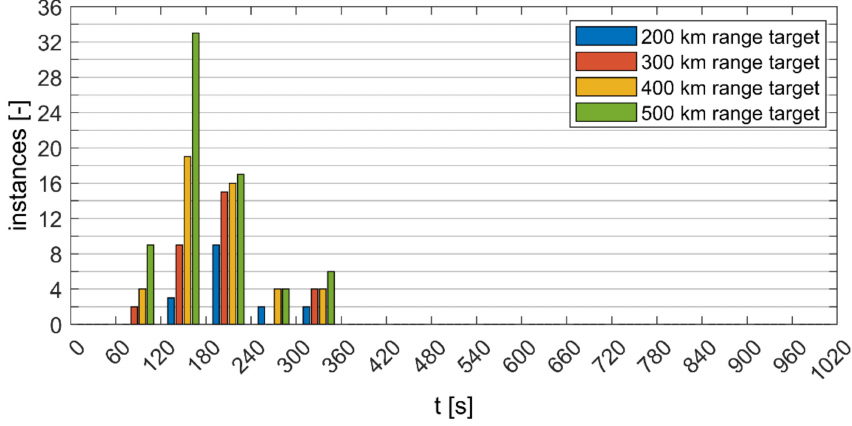
Figure A5. REX engagement instances binned by engagement time for FTP-75 and vehicle mass of 2100